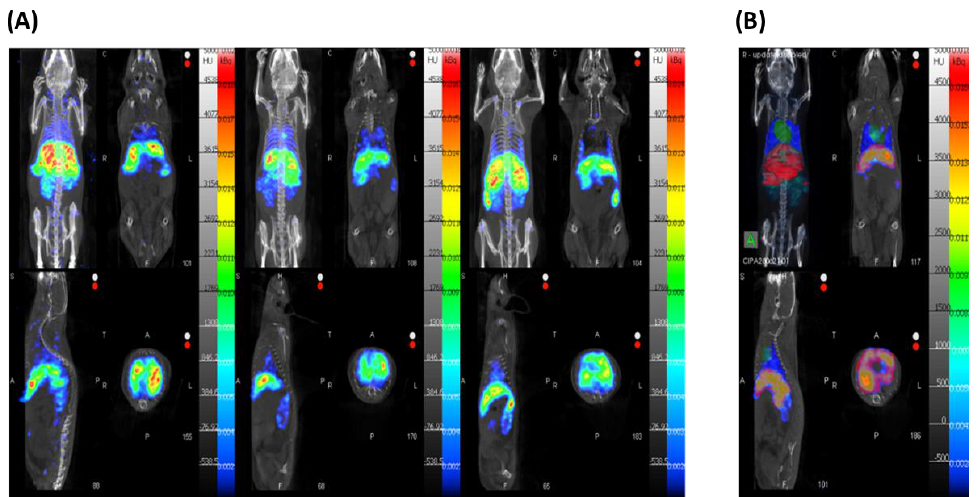
Figure 7. In vivo SPECT/CT images of the optimized NM-scFv-DTPA- 111 In (DTPA/Fe molar ratio: 0.3) ( A ) The 3D reconstructed and co-registered SPECT and CT images are shown together with coronal, sagittal, and axial images (from left to right, up to down). ( B ) Quantification of NMs accumulation by liver, heart, and lungs with VOIs.